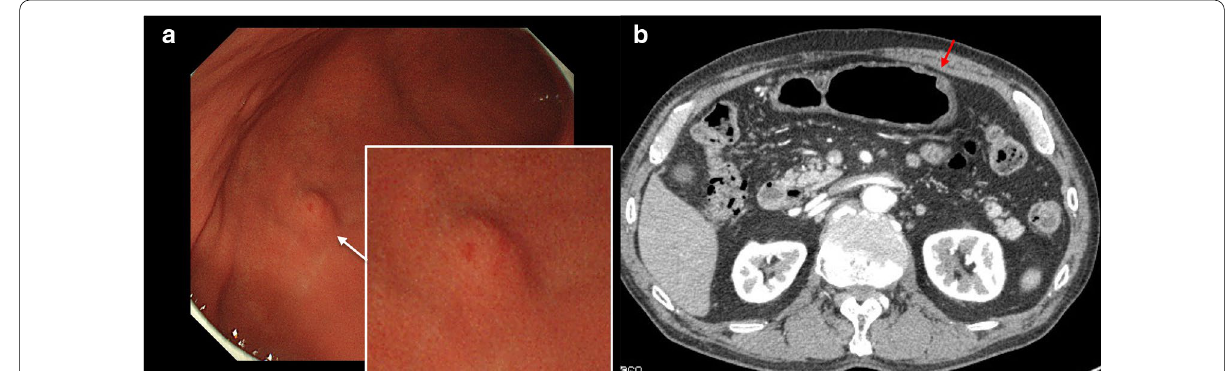
Fig. 1 a An SMT 7 mm in diameter was revealed at the greater curvature of the angulus by upper gastrointestinal endoscopy. b The SMT was detected by contrast-enhanced CT